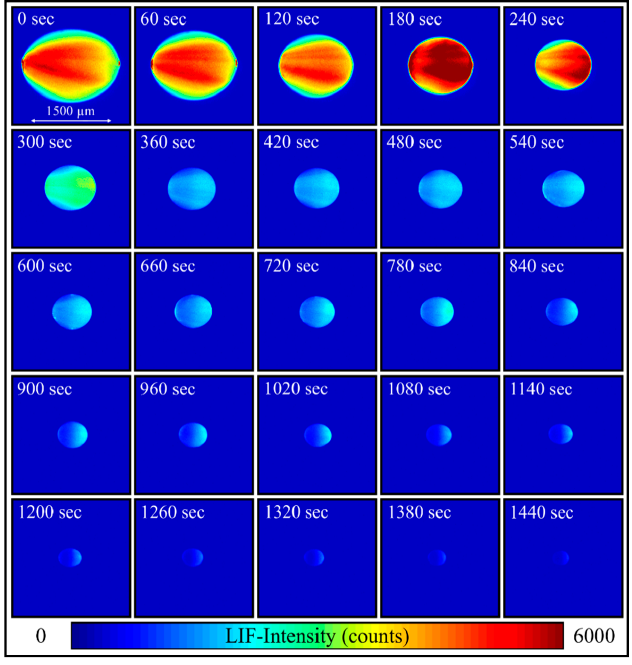
Figure 12. Sequence of a single evaporating droplet (initial temperature: 293 K), illumination frequency 1/60 Hz, the light sheet enters the droplet from the right).